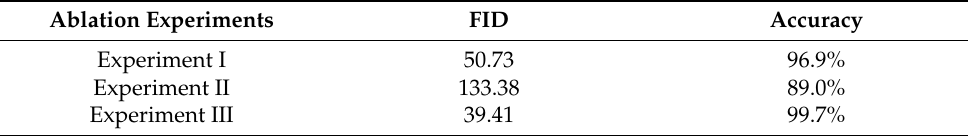
Table 2. FID and accuracy of the three-step ablation experiments. Experiment I: only adding FAB to the discriminator; Experiment II: only adding the FFT and IFFT to the generator; Experiment III: our integrated